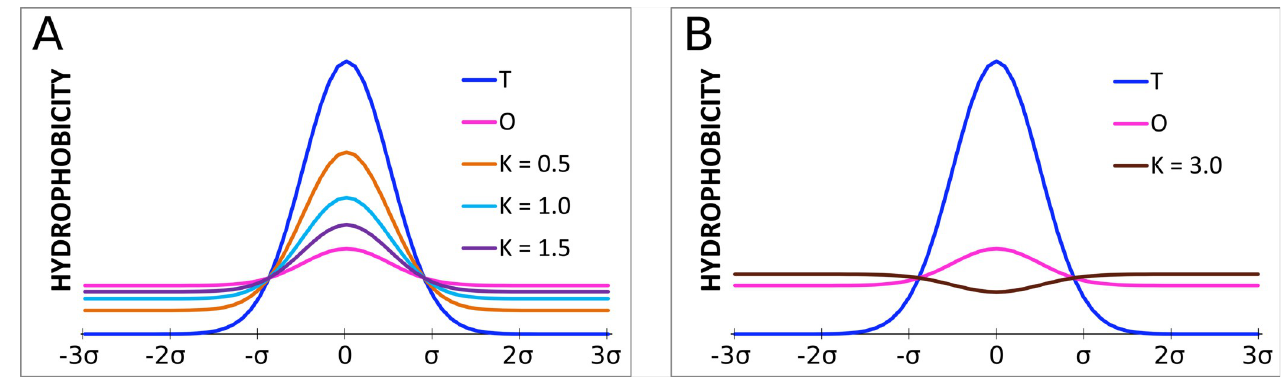
Fig 11. A: The comparison of plots of distributions M for the three different values of K ; B: Plot of distribution M for a very high value of K (3.0). The distributions T and O marked in navy blue and pink respectively.